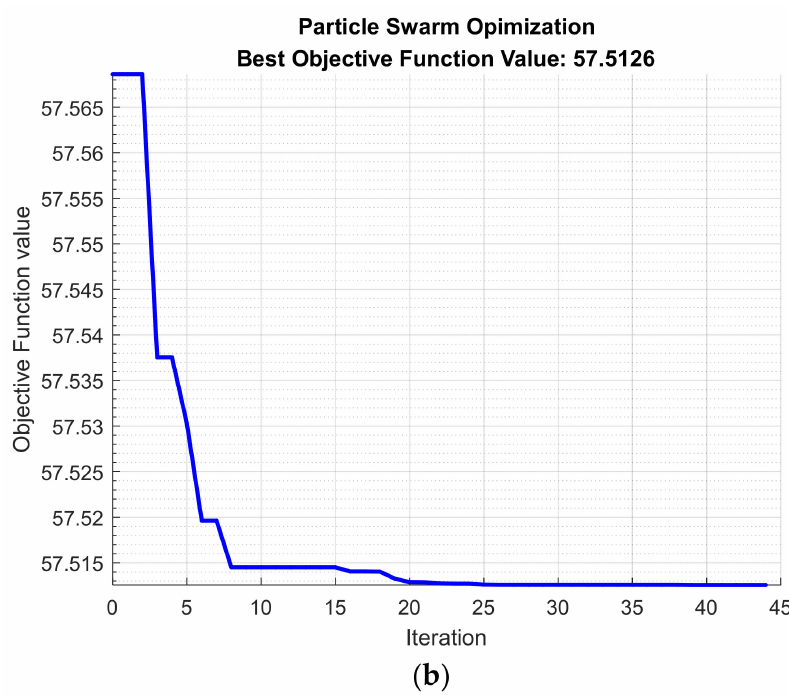
Figure 7. PSS parameter tuning by particle swarm optimization: ( a ) objective function optimization flowchart and ( b ) particle swarm optimization results for PSS parameter